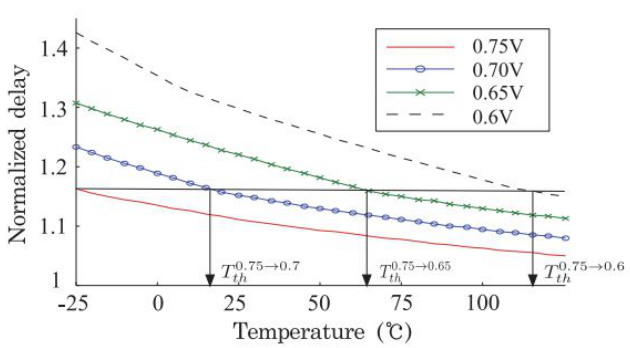
Figure 2. Concept of voltage scaling technique using the TEI phenomenon.